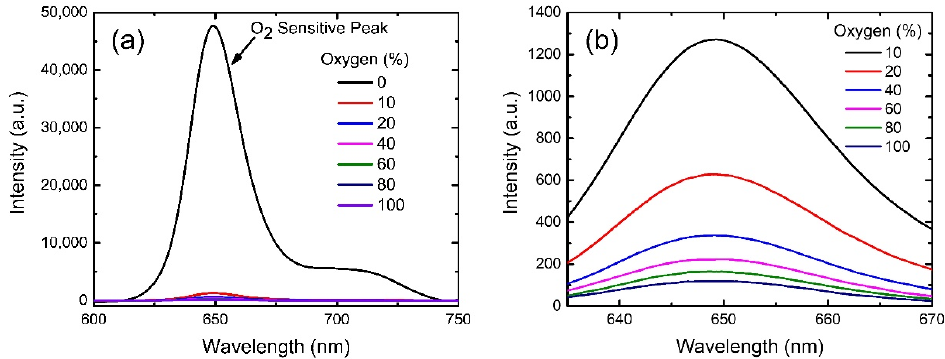
Figure 5. ( a ) Emission spectra of the PtTFPP molecules on an AAO membrane with increasing steps of oxygen concentrations from 0–100%. ( b ) Enlarged plot from ( a ) for better visualization.